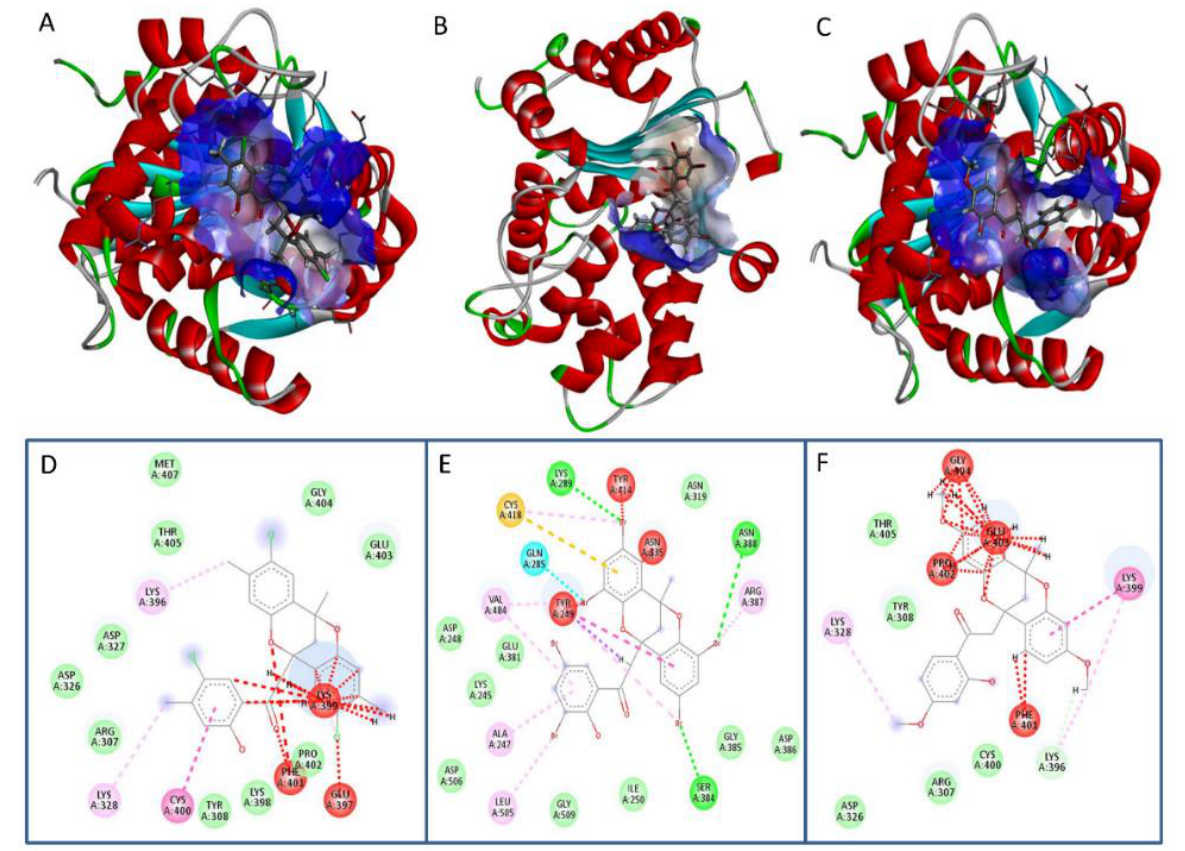
Figure 2. Three-dimensional representation of top docking poses of: ( A ) glutaminase- 3 , ( B ) glutaminase- 5 , and ( C ) glutaminase- 6 complexes. The two-dimensional chemical interaction diagrams of: ( D ) glutaminase- 3 , ( E ) glutaminase- 5, and ( F ) glutaminase- 6 complexes. Table 2. In silico-predicted absorption, distribution, metabolism, excretion, and toxicity properties for dioxocins 1–7. Abbreviation of descriptors are mentioned as follows: human gastrointestinal